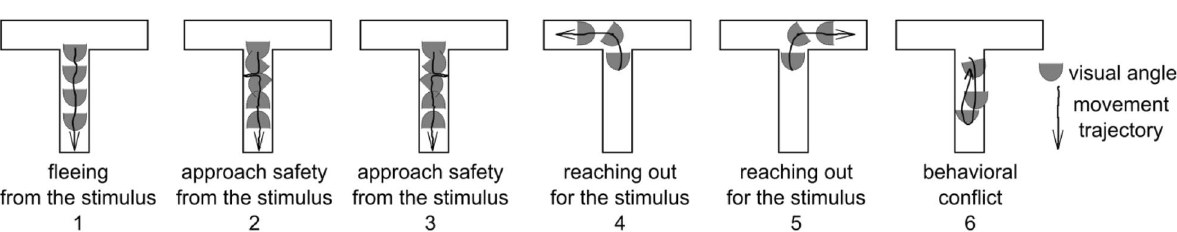
Figure 2. Behavioral categories in the virtual T-maze. The numbers show the different classes that are later used for classification. Note that the behavioral conflict category is not only two different behaviors in one trial but also very bad performance compared to the other trials of the participant. Note also, that the category 2 and 3 are both approach safety behaviors, yet their difference is in the turning direction. This may be interesting dependent on the question on is to